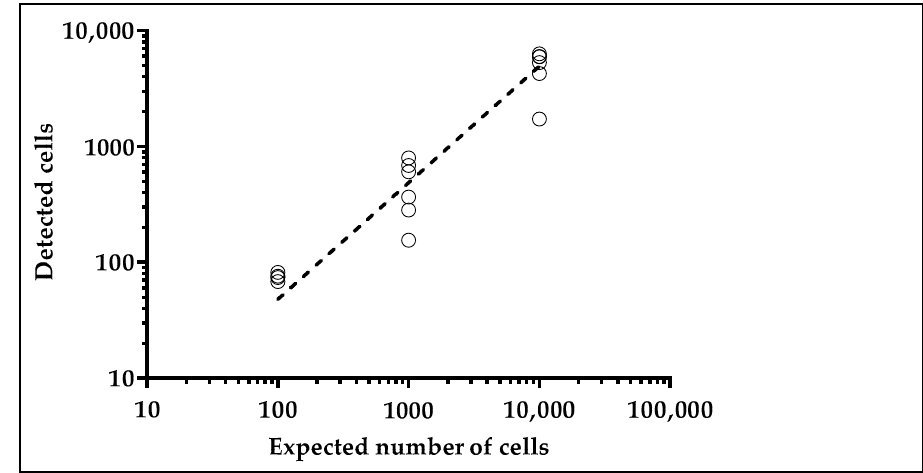
Figure 4. Series of spiking assays with cancer cells pre-labeled with Hoechst. Number of Hoechst positive (detected) cells with respect to the number of spiked ones (expected cells).